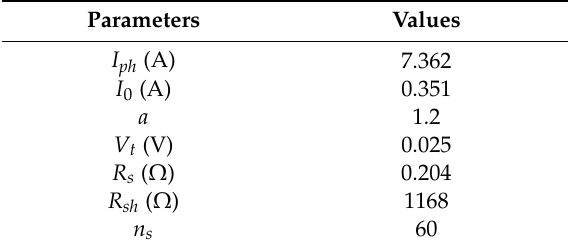
Table 2. Estimated input parameters of a PV module.